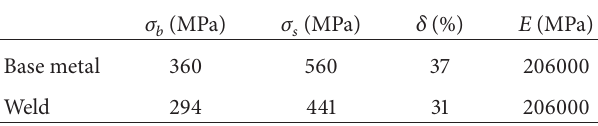
Table 1: Mechanical property of 16Mn steel and weld.